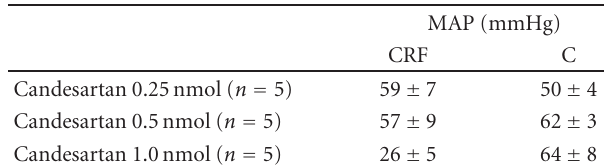
Table 2: Values of mean arterial pressure increase (delta of MAP) in response to Candesartan microinjection into the RVLM in hypertensive (CRF) and control (C)